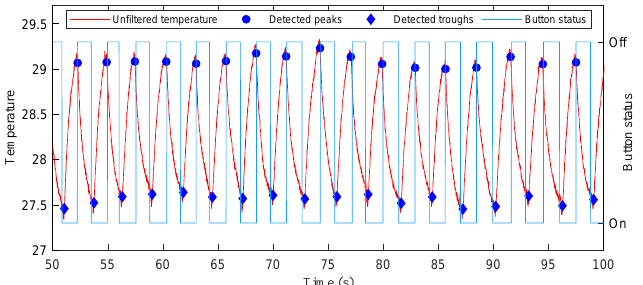
Figure 12. The recorded temperature and button status in a test of stationary mode.